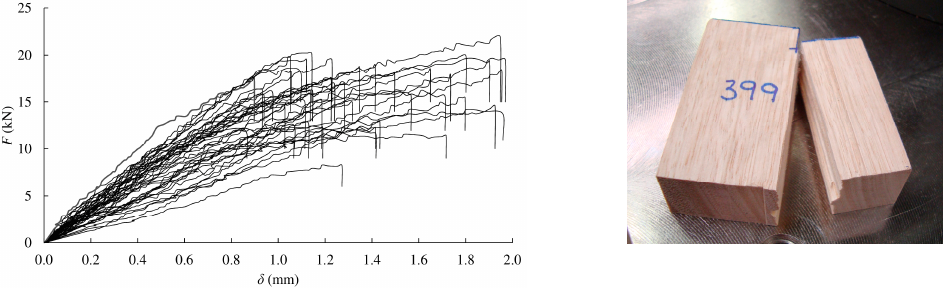
Figure 7. Shear: load-displacement curves ( left ); typical failure mode ( right ).